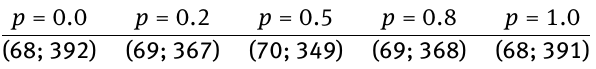
Table 4.1: Sharp VaR bounds with marginal information only d = 100 , α = 0.95 . p = 0.0